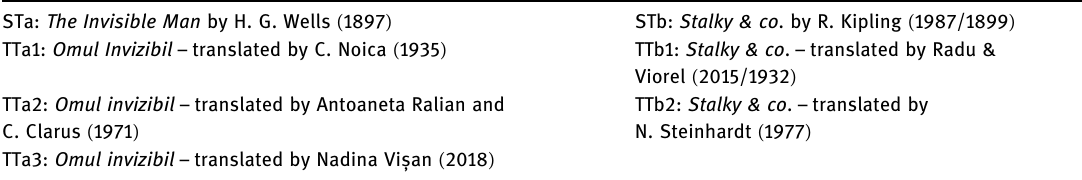
Table 3: Information about the Corpus STa: The Invisible Man by H. G. Wells ( 1897